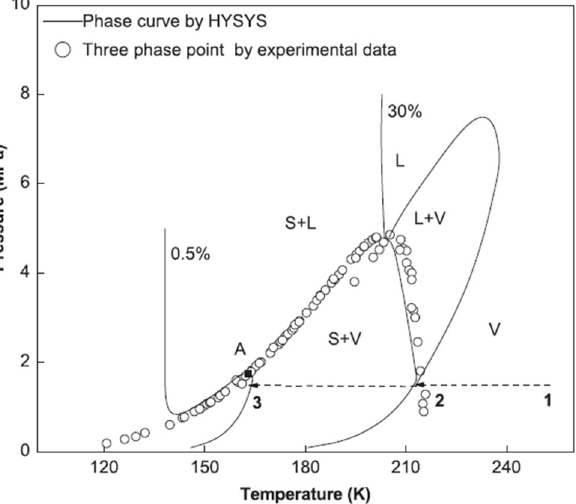
Figure 52. Phase diagram of CH 4 -CO 2 binary system at different CO 2 contents [203]. Reprinted